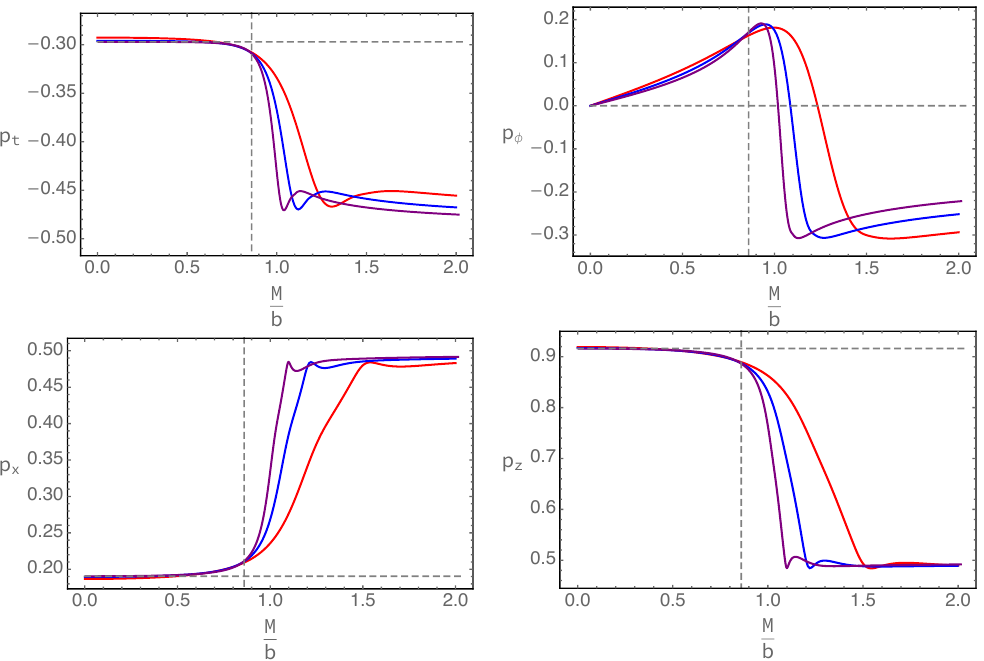
Figure 5 . Plots of Kasner exponents for holographic NLSM as functions of M/b . For all cases we have T/b = 0 . 05 (red), 0 . 02 (blue), 0 . 01 (purple). The horizontal dashed gray lines represent the Kasner exponents for M/b = 0 at T/b = 0 . 01 . The vertical dashed gray lines represent the quantum critical point at zero